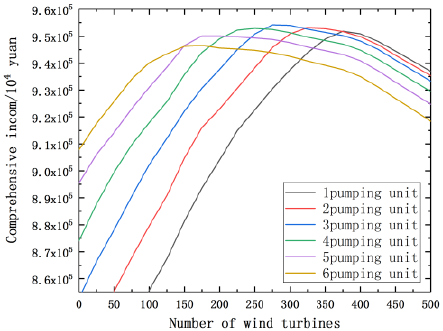
Figure 8. Capacity allocation comprehensive income of strategy 2.